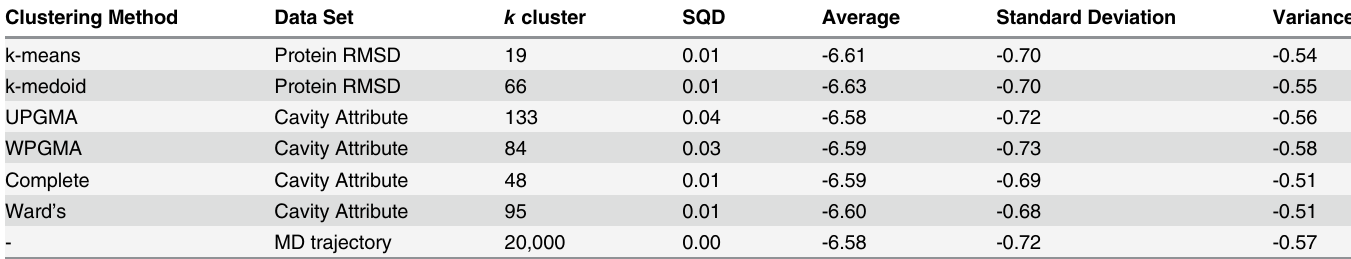
Table 3. Statistical evaluations for the optimal partitioning solutions obtained from the best partitions (lowest SQD value) of every clustering method. Third column indicates the number of medoids used in the statistical assessments. Average, standard deviation and variance were calculated for each set of medoids based on predicted FEB values. Last row indicates the statistical values for the MD ’ s full